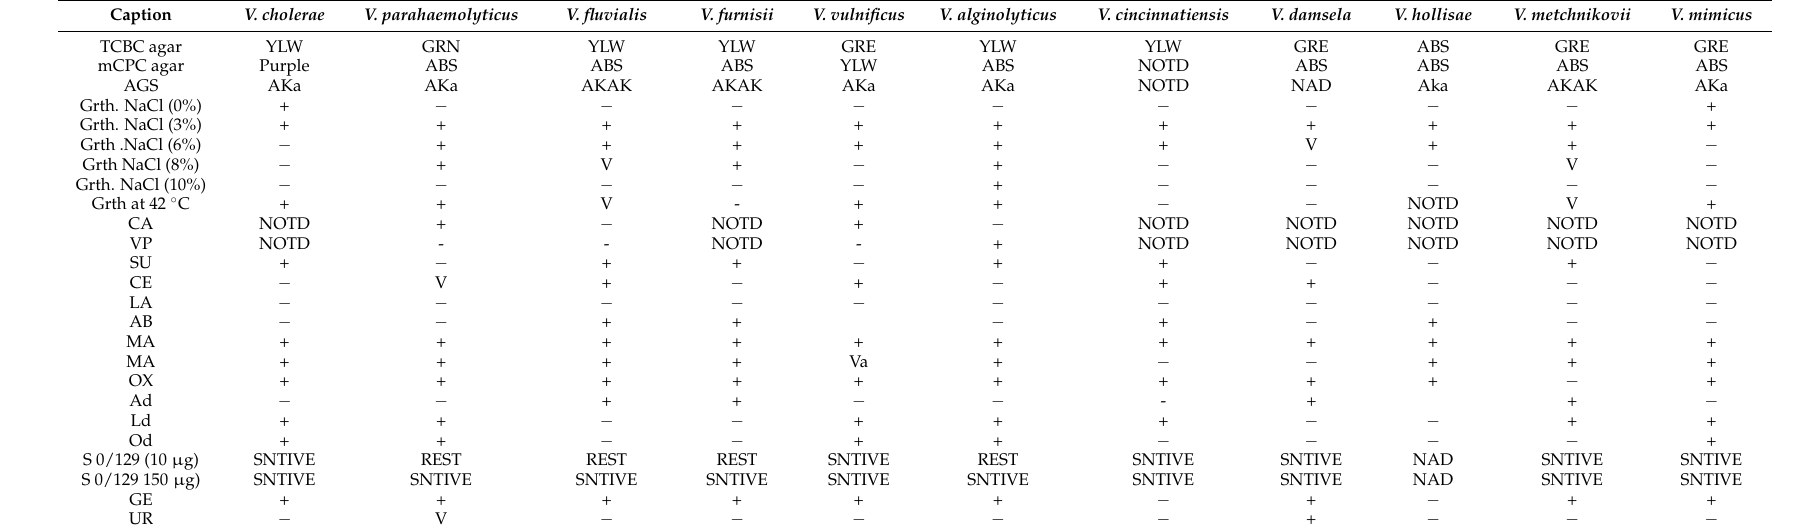
Table 2. Biochemical characterization of some Vibrio